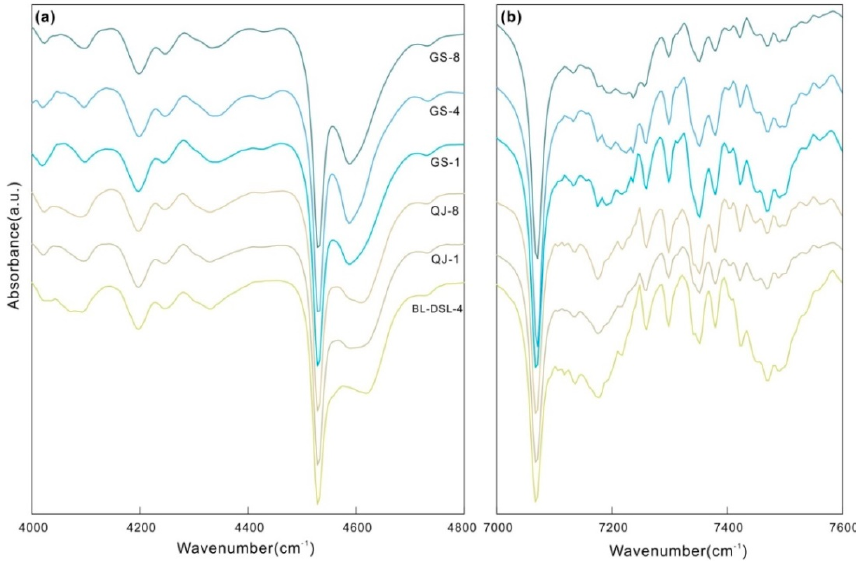
Figure 6. NIR spectra of the kaolinite and dickite samples. ( a ) The range of the OH combination